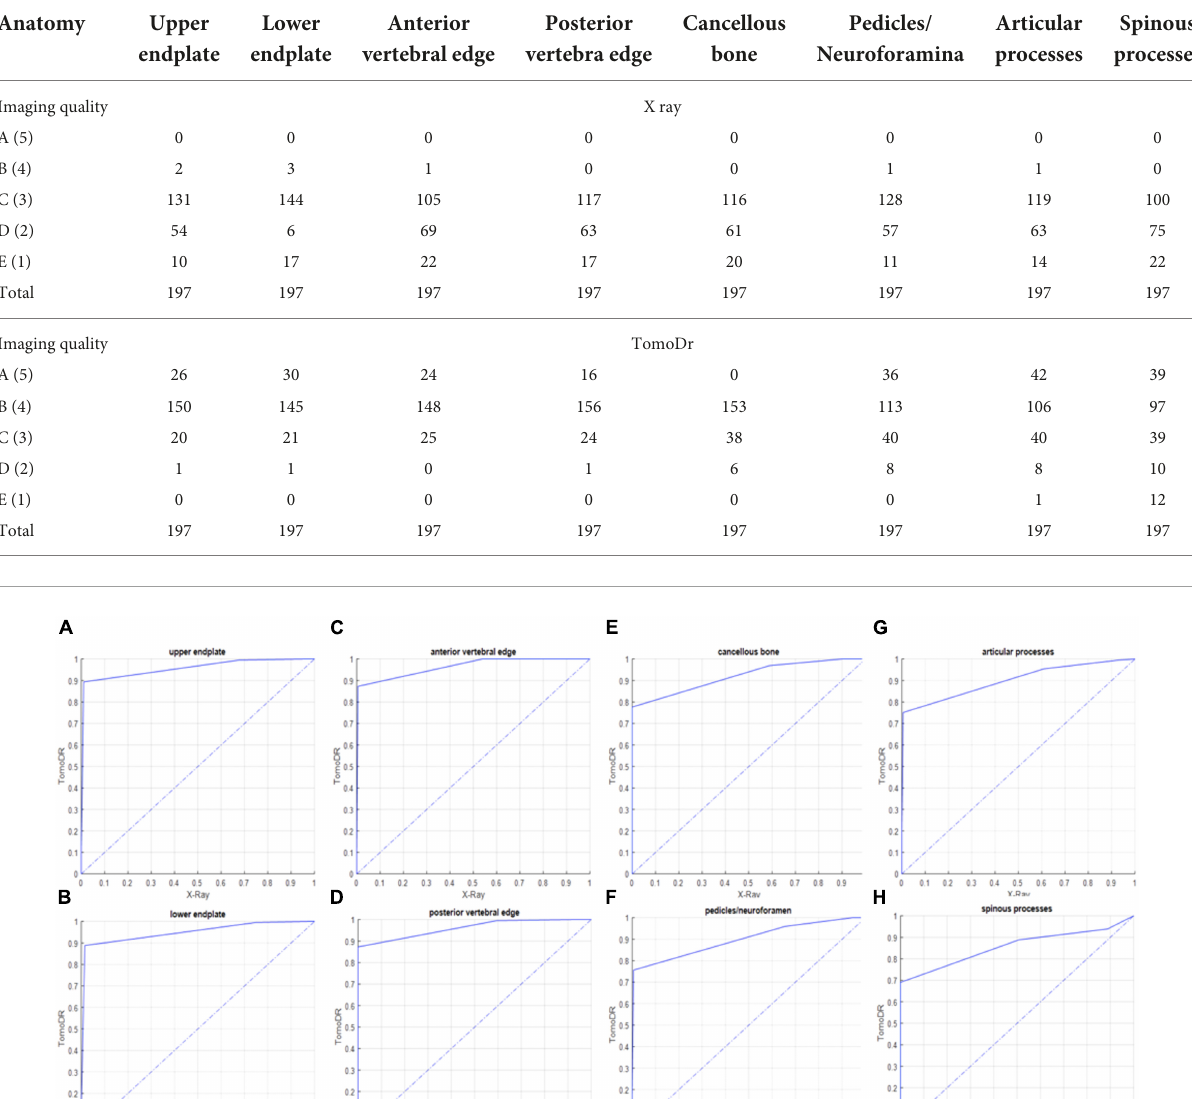
TABLE 3 The results of the image quality score analysis.